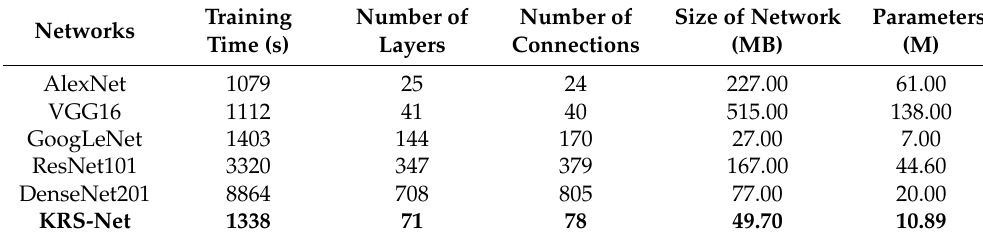
Table 4. Parameters and training times of six classification